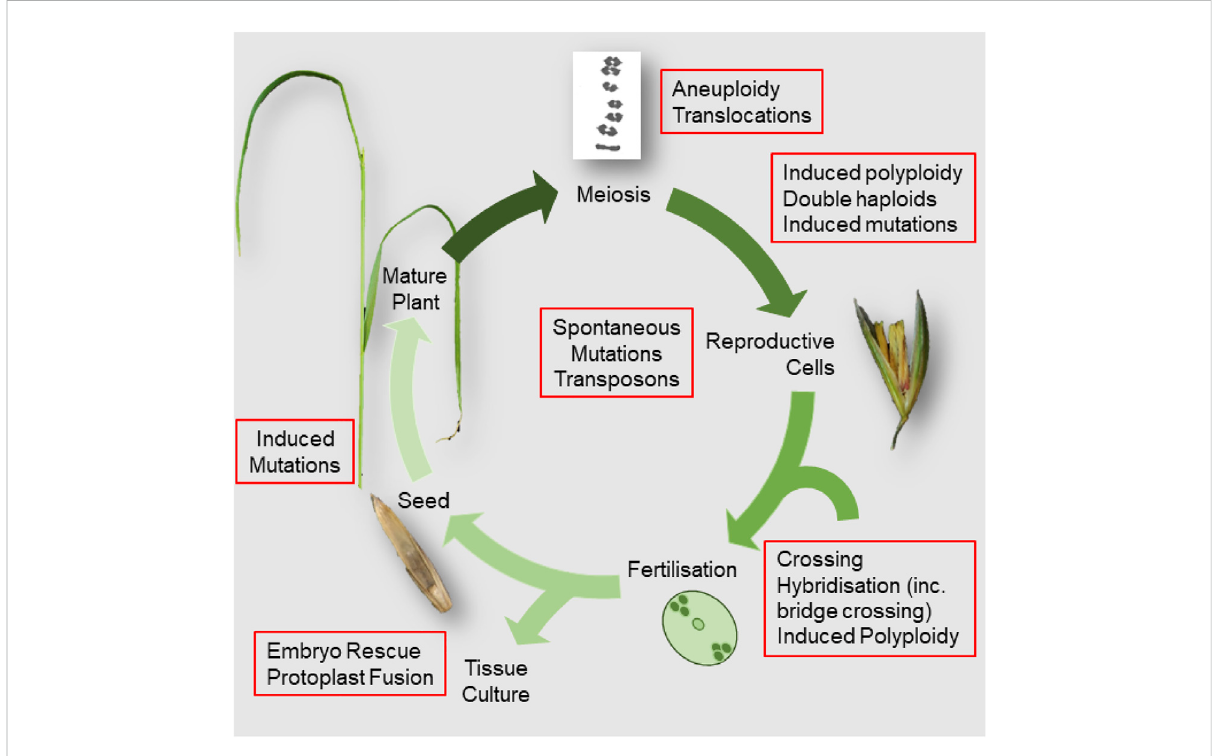
FIGURE 1 Diagram summarising the fl owering plant life cycle showing breeding activities and sources of